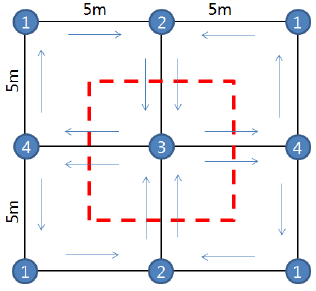
Figure 8. Scanning procedure and path of moving tag.